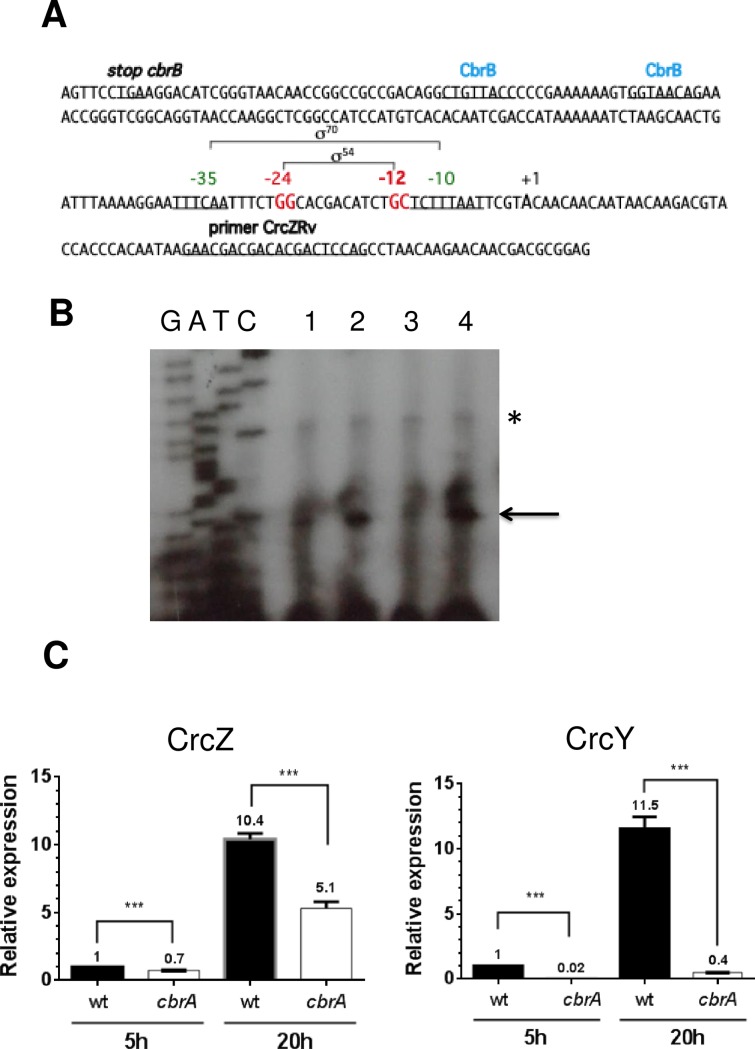
Transcriptional regulation of CrcZ and CrcY sRNAs.A. DNA sequence of the regulatory region of crcZ. The transcriptional initiation site is indicated (+1), along with the predicted σ70 and σ54 promoters. The putative sequences recognized by CbrB are indicated. B. Identification of the transcription initiation site of crcZ. The primer extension analysis was conducted with RNA extracted from cells grown in BAG (lanes 1 and 2) or BAG-N (lanes 3 and 4) medium, during growth at the expense of acetate (lanes 1 and 3) or glucose (lanes 2 and 4). A primer complementary to crcZ was used and its sequence is indicated in panel A. The cDNA obtained was resolved in a denaturing poly-acrylamide gel, side by side with DNA sequence ladders obtained by chemical sequencing of crcZ. The transcriptional initiation site is indicated by an arrow. A second signal, corresponding to a transcript 13 nt longer than the primary one, is also indicated (*). C. Quantification of CrcZ and CrcY transcripts by qRT-PCR analysis in the wild type train AEIV (wt) and in its derivative cbrA::Sp mutant EQR02 (cbrA), grown in diauxic BAG medium at the expense of acetate (5h) or glucose (20 h). The bars of standard deviation from three independent experiments are shown. Significant differences were analyzed by t-test. Statistical significance is indicated (***p<0.001).